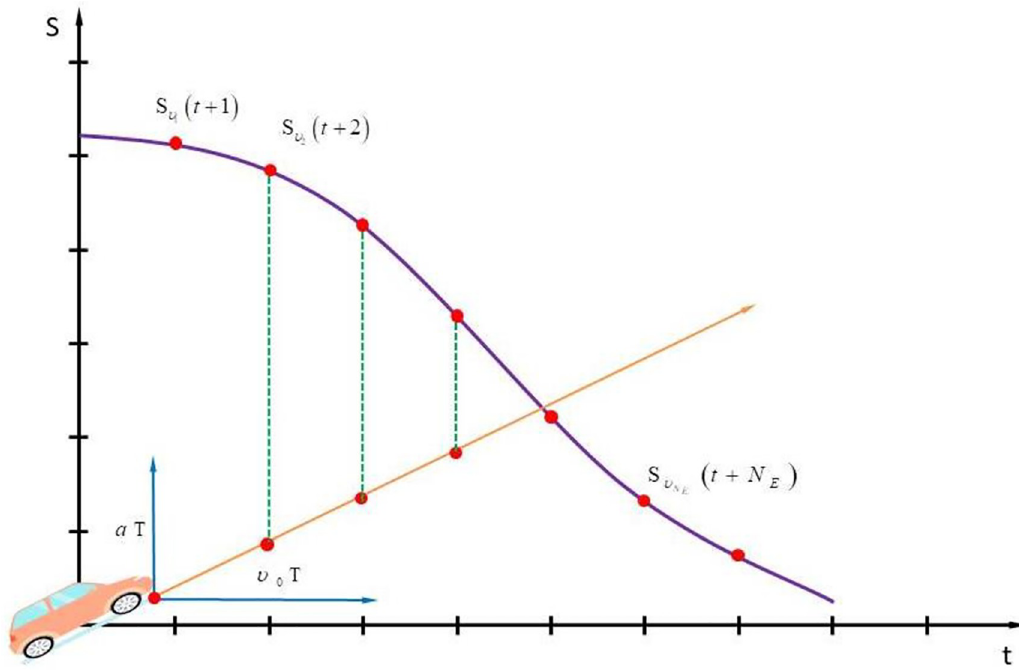
Fig 2. Diagram of the expected driving state in the dilemma